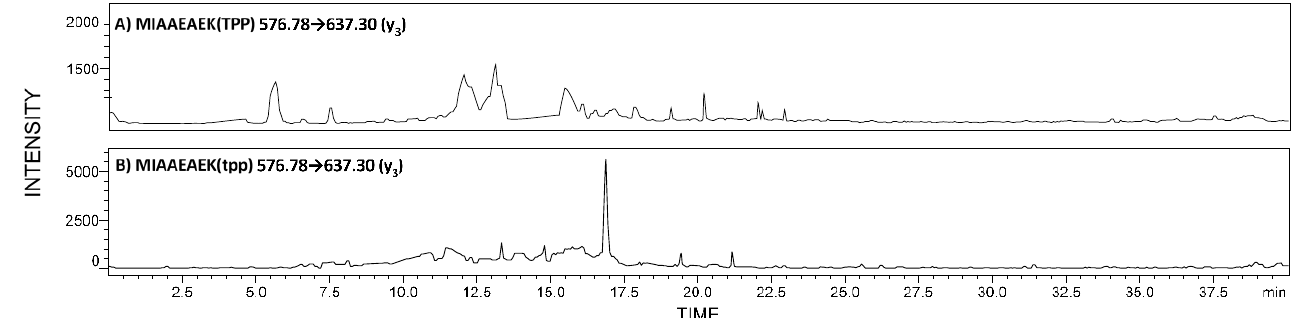
Table 4. Comparison of the clinical LC-MS/MS and ELISA data for the diagnosis of preeclampsia. Levels of podocin in human urine samples based on the ELISA test. Results were normalized and values were calculated regarding a standard curve, obtained for podocin-coated wells. “Undetectable” means a reading below the detection level; PE, preeclampsia; “+”, positive result; “-”, negative result. Podocin Level at the Podocin Level at the End Patient No. Beginning of Pregnancy % Change of Pregnancy (ng/mL) (ng/mL) 1 1.166 0.473 2